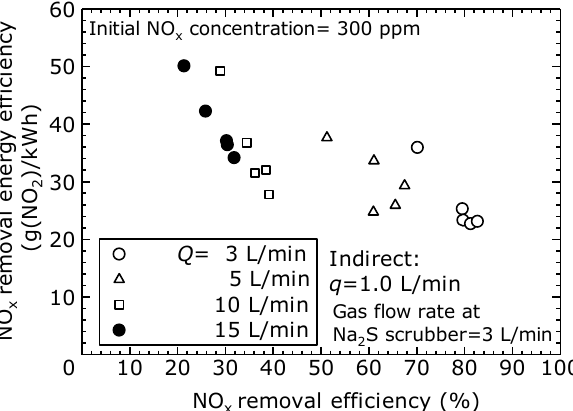
Figure 10. Measurement relation between NO x removal efficiency and NO x removal energy efficiency at different flow rate by the indirect oxidation method. (The NO x removal energy efficiency is calculated as total flow rate Q = 3 – 15 L/min from the inflow rate of exhaust gas to the chemical scrubber of Q s = 3 L/min).